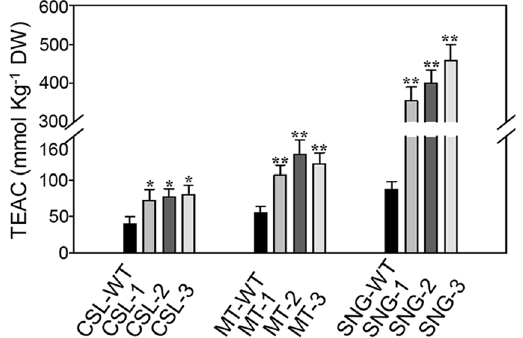
Figure 7. Total antioxidant capacity in wild-type and SlMYB12 -overexpressing tomatoes. Fresh and skin antioxidant activities in mature tomato fruits of each cultivar. Three different tomato fruits of each cultivar were pooled for detection. CSL-WT, Csl03-09 wild-type; MT-WT, Micro-Tom wild-type; SNG-WT, Sheng Nv-Guo wild-type. CSL-1, CSL-2, CSL-3, MT-1, MT-2, MT-3, SNG-1, SNG-2, and SNG-3 indicate the T 1 heterozygous lines of each variety. Each value represents repeated four times independent experiments, and the vertical bars expressed the arithmetic means ± standard deviations (SD). ** P < 0.01, * P <